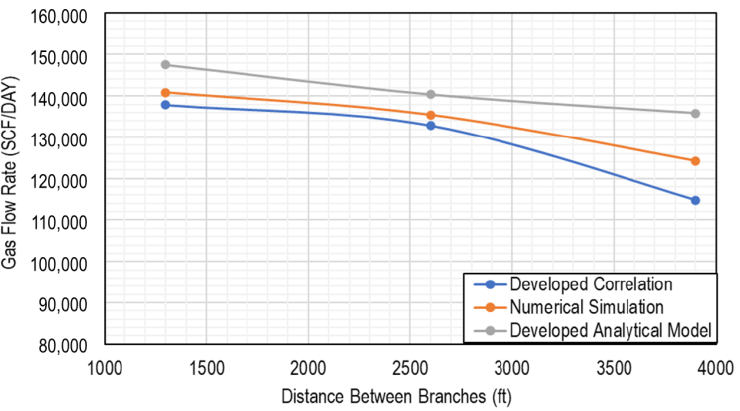
Figure 15. The effect of the distance between adjacent branches on the cumulative production.